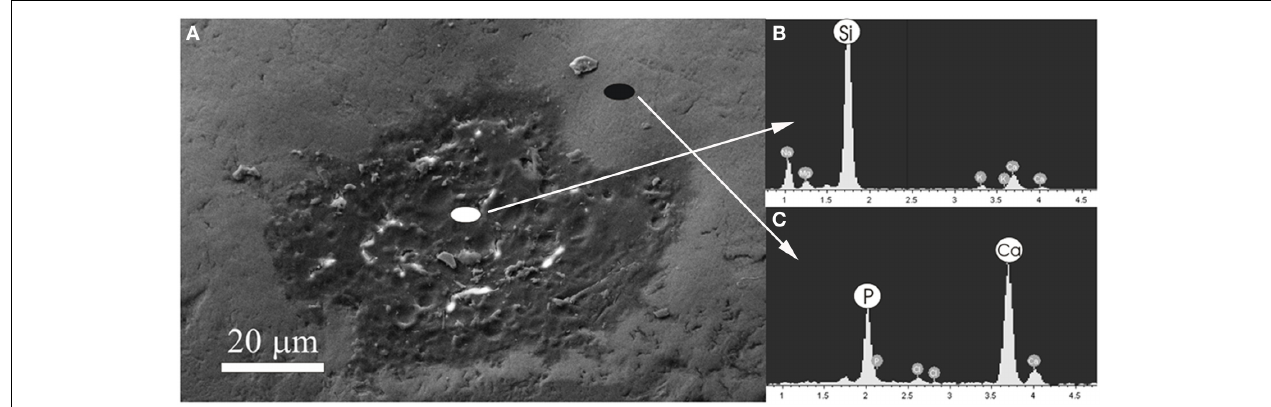
FIGURE 5 | Scanning electron micrograph of the enamel surface of a tooth in vivo treated using the KNO 3 /NaF toothpaste (A), EDAX with probe pointed in the area labeled by the white circle (B), EDAX with probe pointed in the area labeled by the black circle (C).